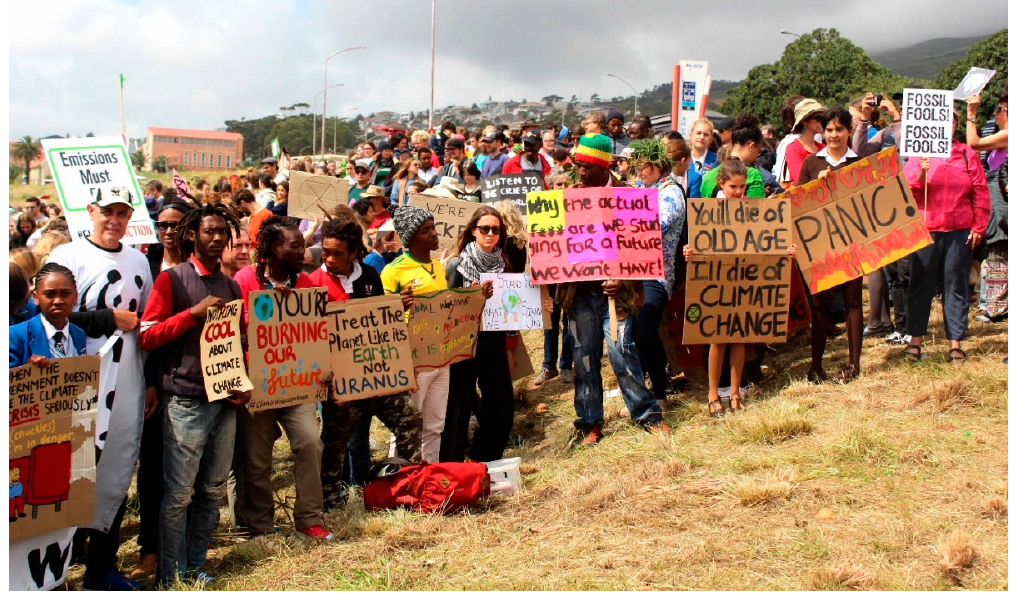
Figure 1. #ClimateStrike protestors in Cape Town, September 2019. Photo: Masixole Feni / GroundUp.